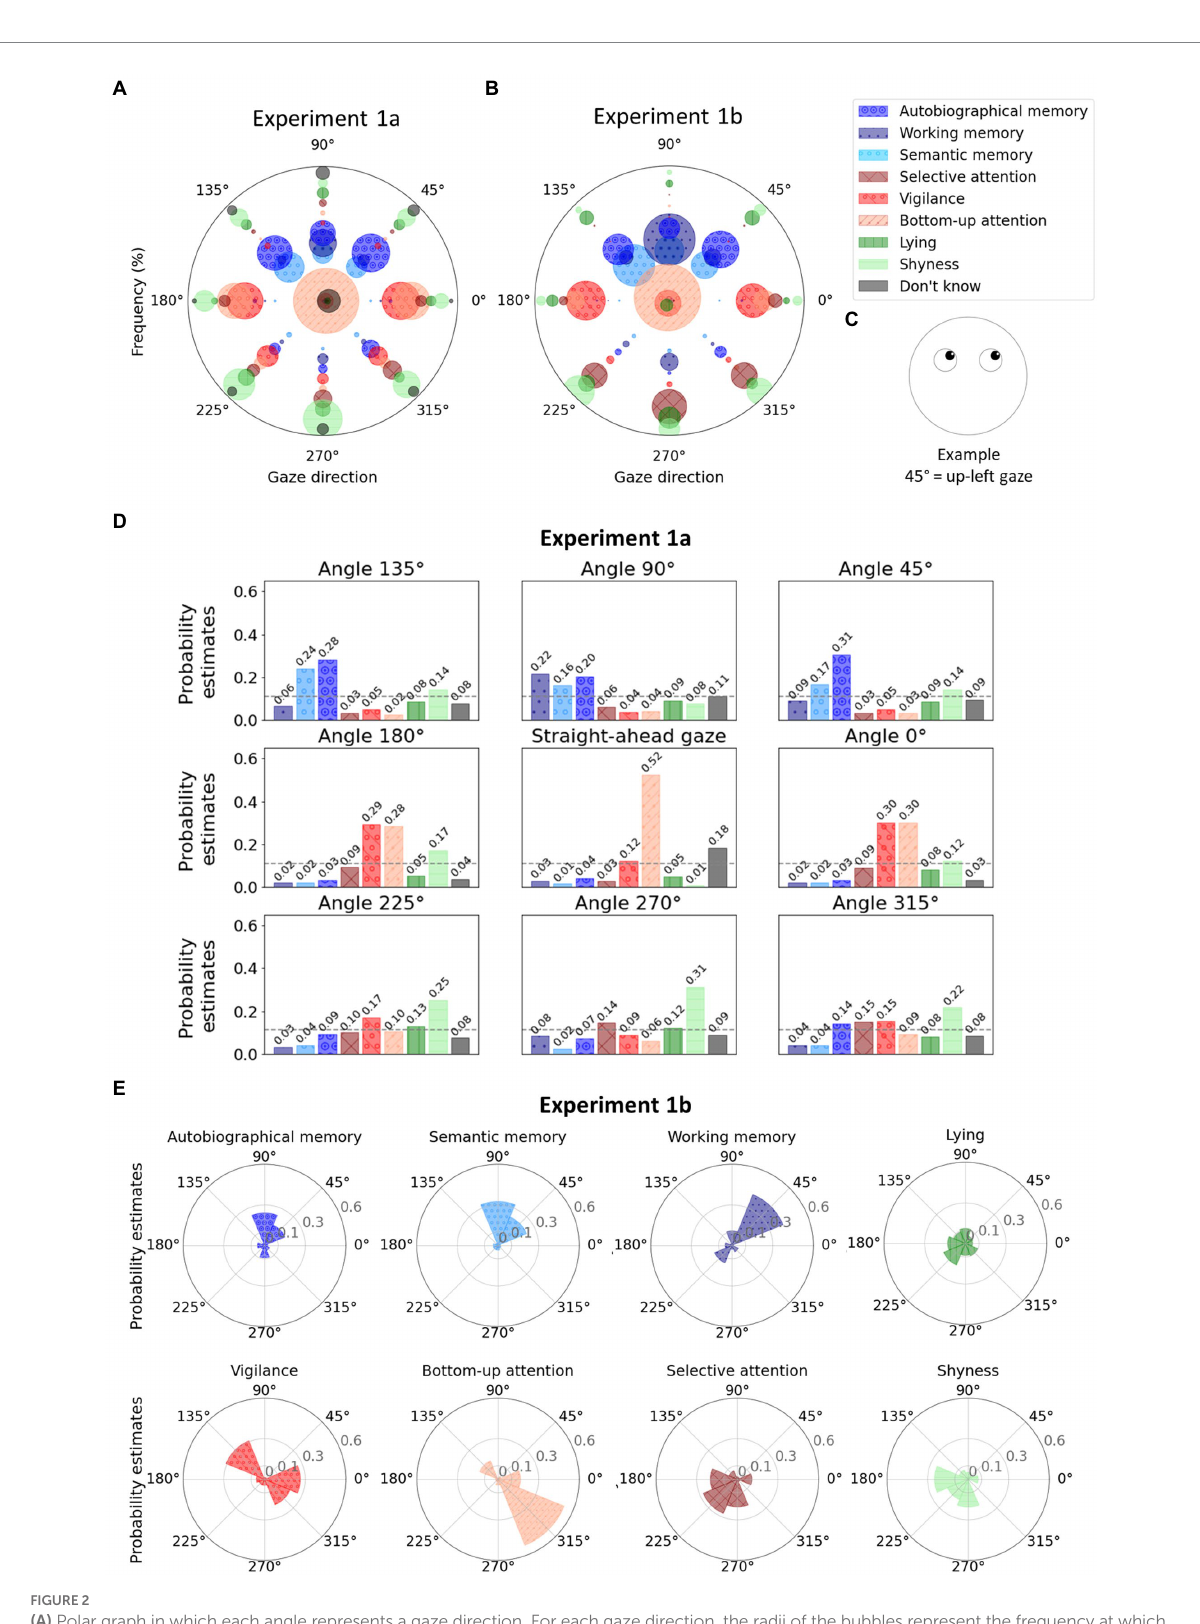
FIGURE 2 (A) Polar graph in which each angle represents a gaze direction. For each gaze direction, the radii of the bubbles represent the frequency at which a given mental state (see colors) was associated with the given gaze direction during Experiment 1a. The size of the bubbles depends on the frequency of the responses. Note that the position of the bubbles along the y-axis has no meaning and was chosen to avoid